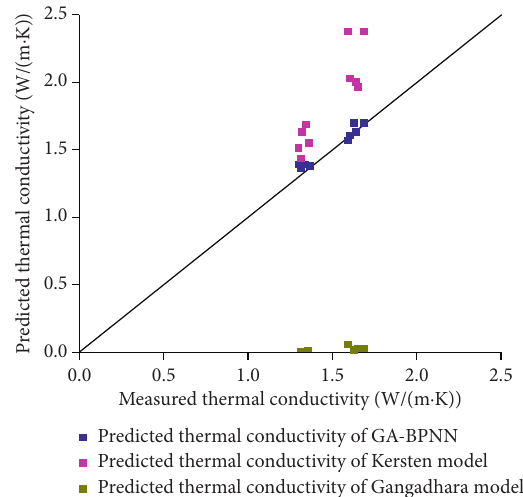
Figure 7: Comparison of predicted thermal conductivity between GA-BPNN and empirical